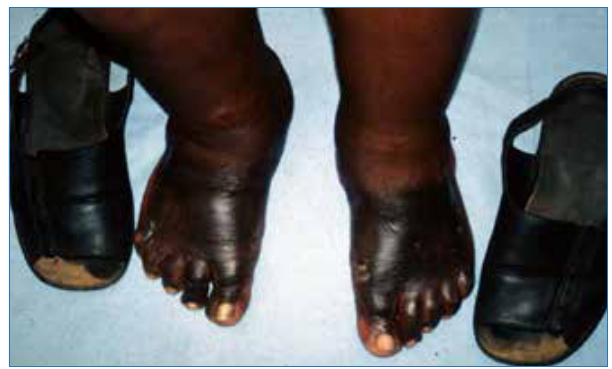
Figure 2: Allergic contact dermatitis due to shoes